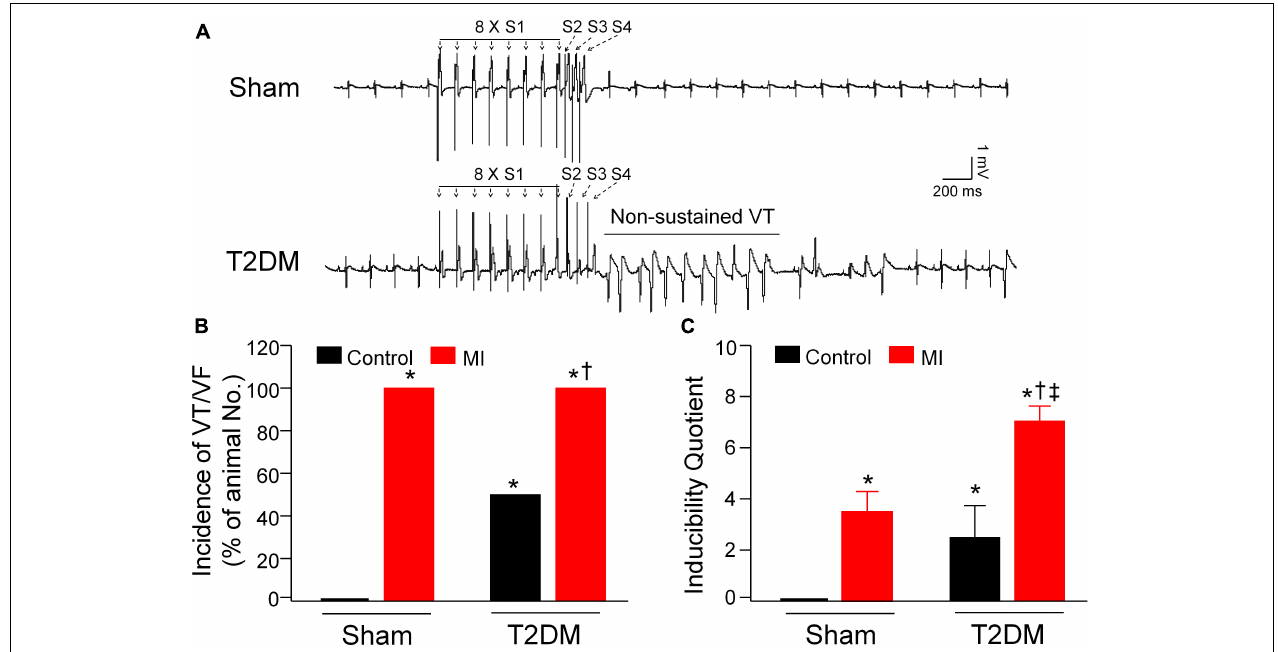
FIGURE 3 | Susceptibility to ventricular arrhythmias determined by programmed electrical stimulation (PES) in all experimental groups of anesthetized rats. (A) : Raw data for PES-evoked ventricular tachycardia/fibrillation (VT/VF) in anesthetized sham and T2DM rats. (B,C) : Mean data for incidence (B) and inducibility quotient (C) of PES-evoked VT/VF in all groups of anesthetized rats. Compared with sham rats, a high incidence of VT/VF and inducibility quotient were found in T2DM rats without MI. Both incidence of VT/VF and inducibility quotient were further increased in T2DM rats after MI, compared with sham rats with MI. Data are means ± SEM; n = 3–6 rats per group. Statistical significance was determined by one-way ANOVA with post-hoc Bonferroni test. * P < 0.05 vs. sham; † p < 0.05 vs. T2DM; ‡ p < 0.05 vs.